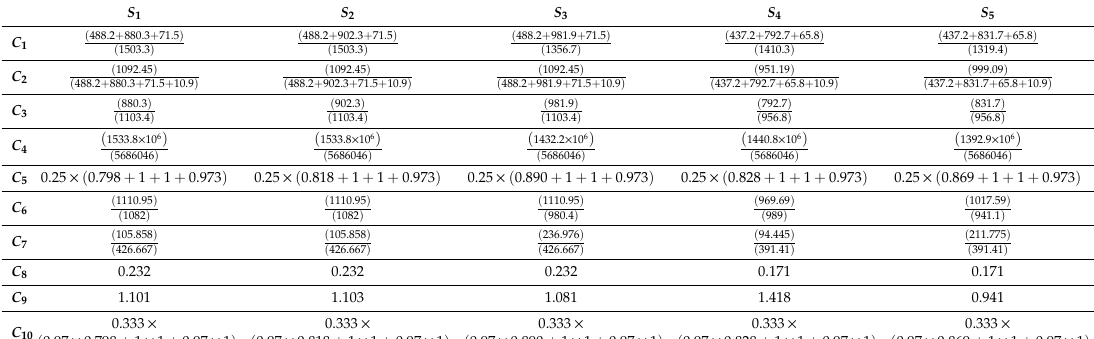
Table A6. The detailed variables for the determination of the evaluation matrix of the water